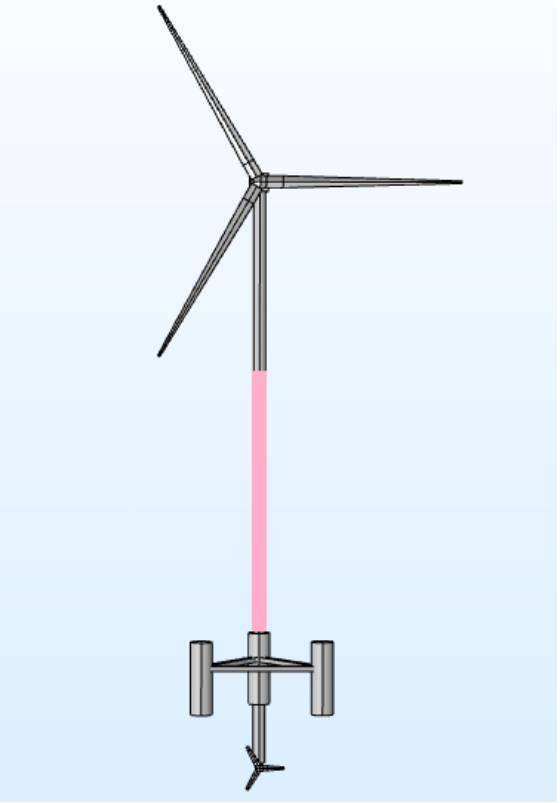
Figure 11. Area where piezoelectric materials will be